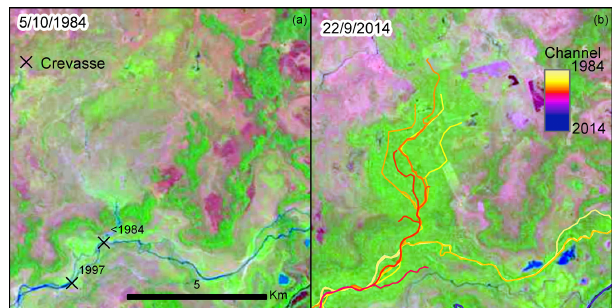
Figure 8. Change in vegetation cover from savannah (reddish) to forest (green). The area covered with savannah in 1984 (a) becomes forested (b) after sediments are deposited by crevasses in the central part of the image. In inset (b) , paleo courses from 1984 to 1999 are drawn.